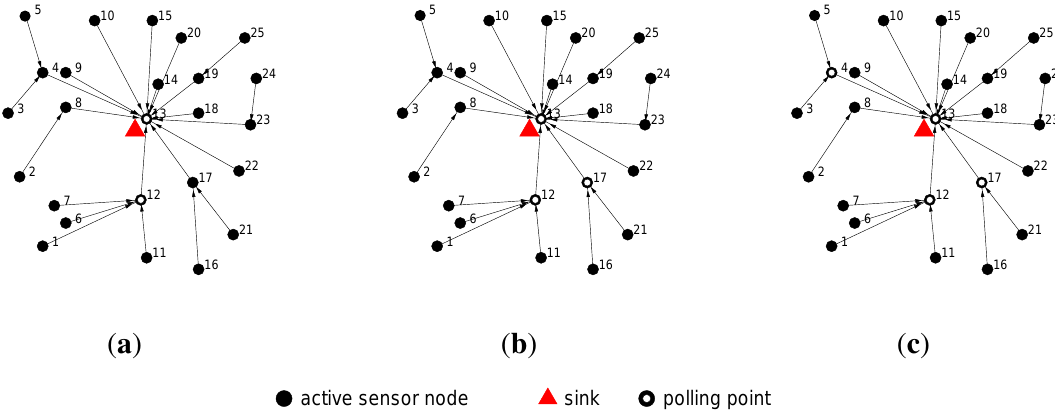
Figure 2. The polling point selection of in-degree priority algorithm (IPA). The black nodes represent the active sensor nodes; the triangle represents the sink, and the hollow nodes represent the polling points selected by the algorithm. IPA iterates four times and selects four polling points.